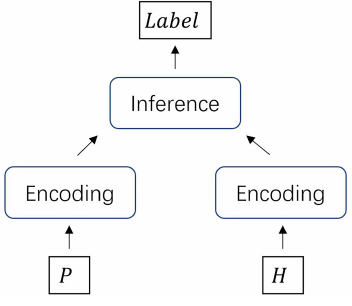
Figure 3. The Siamese framework.